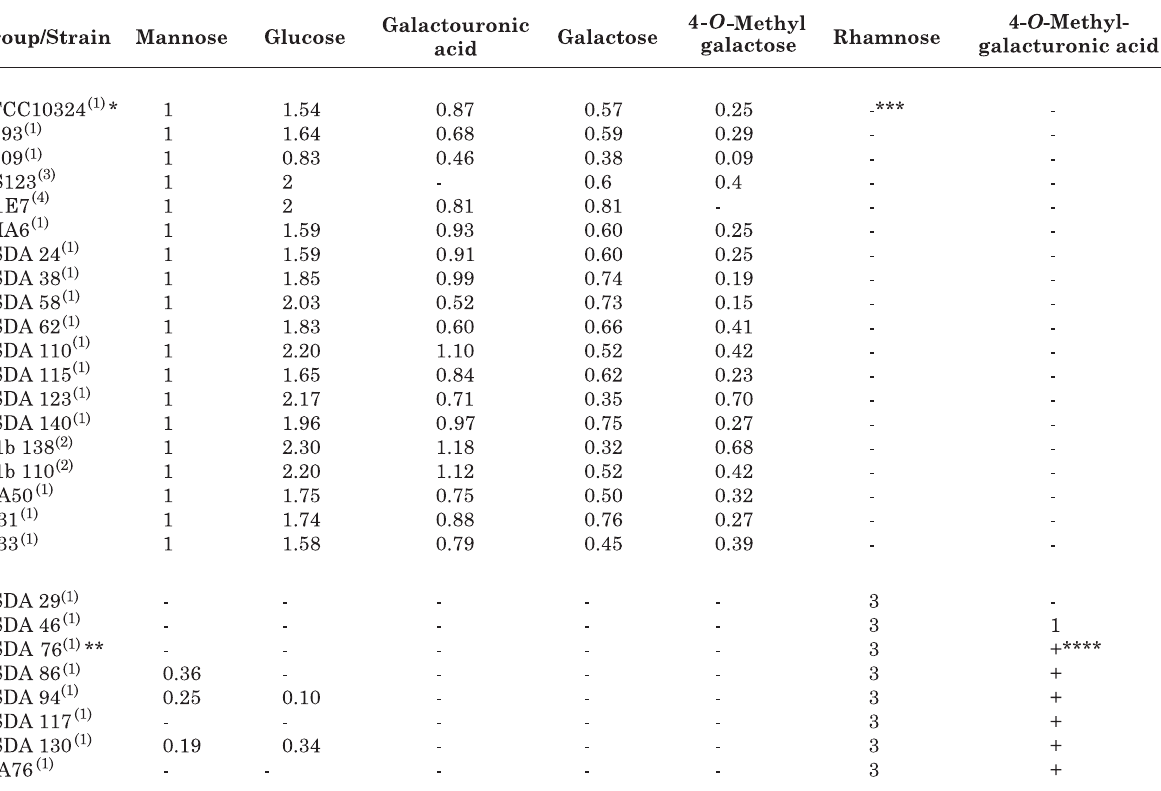
Table 1. Composition of EPS in repeat units normalized to mannose, from the different Bradyrhizhobium japonicum strains previously classified as group I and group II. (Modified and updated from Huber et al., 1984) (Note: Currently group II is classified as B. elkanii